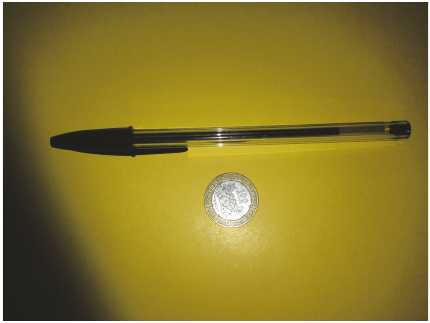
Figure 3: Chest X-ray one month later. This picture was taken the day of his arrival at our hospital. The empyema is loculated, the foreign body is still present in the chest, and the radiological signs of esophageal perforation are more